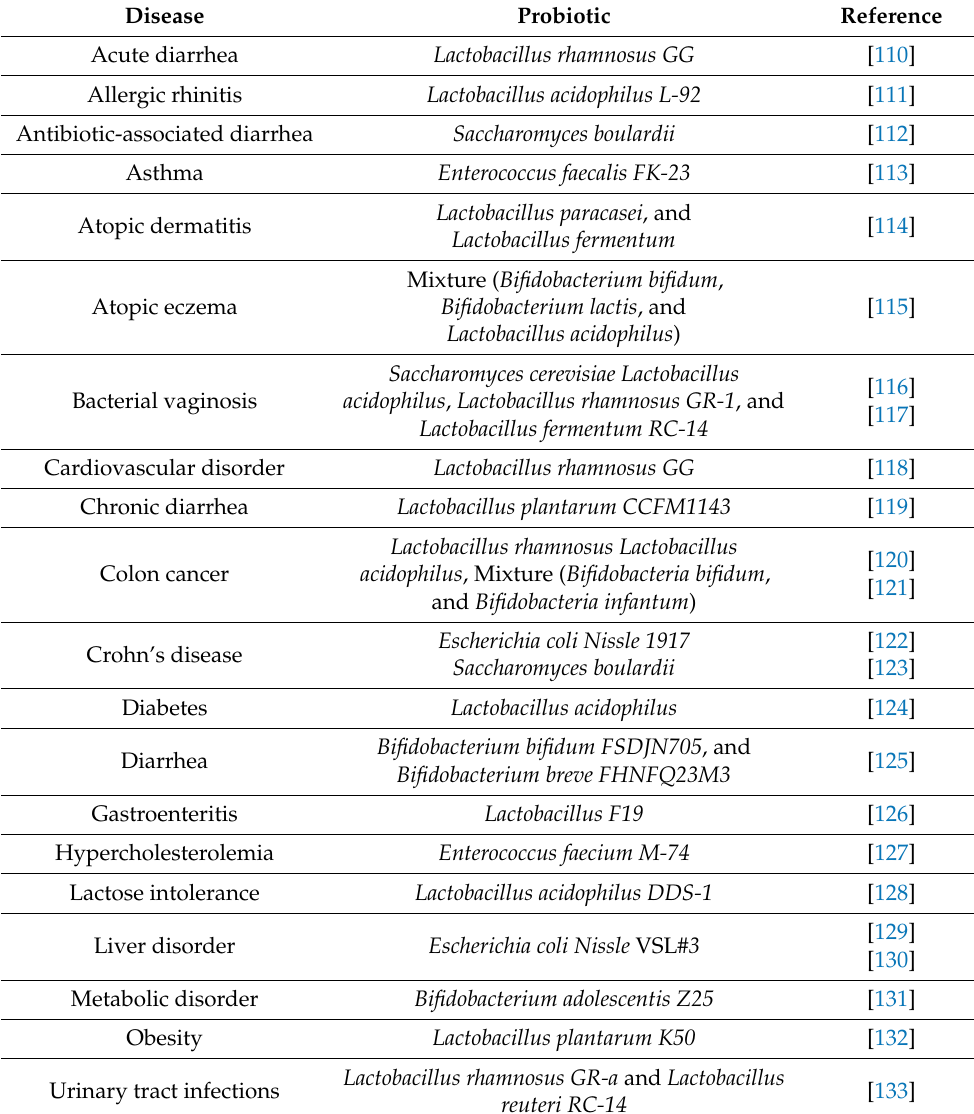
Table 1. Use of probiotics in several